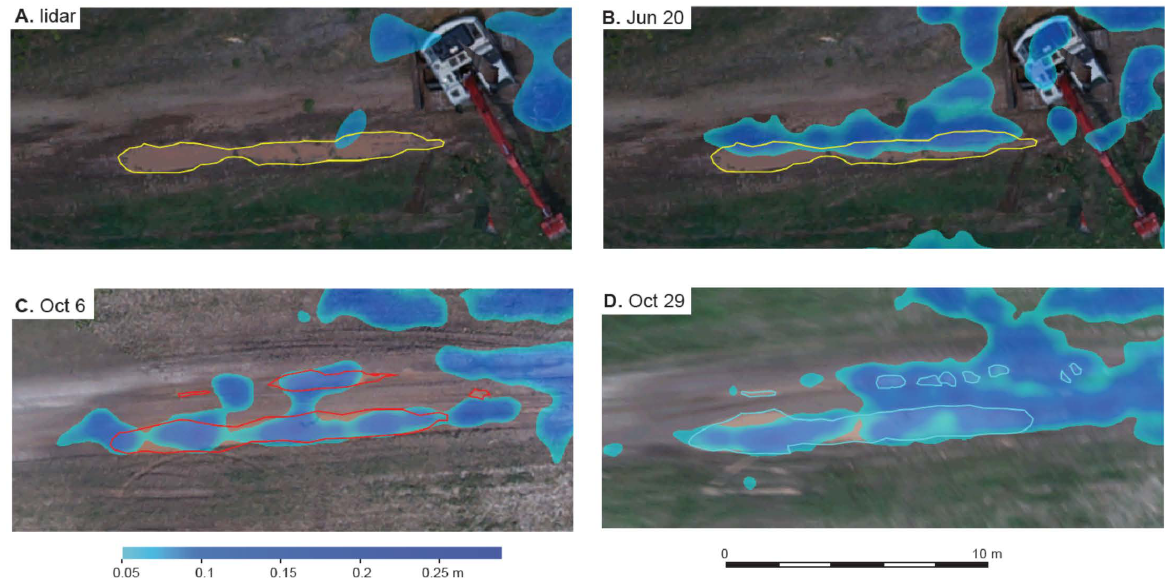
Figure 9: The puddle along the service road (enlarged area D from Figure 5) captured on the orthophoto from Jun 20 (A and B), Oct 06 (C) and Oct 29 (D) with displayed results of overland flow simulations based on lidar based DSM (A) and sUAS data collected Jun 20 (B), Oct 06 (C) and Oct 29